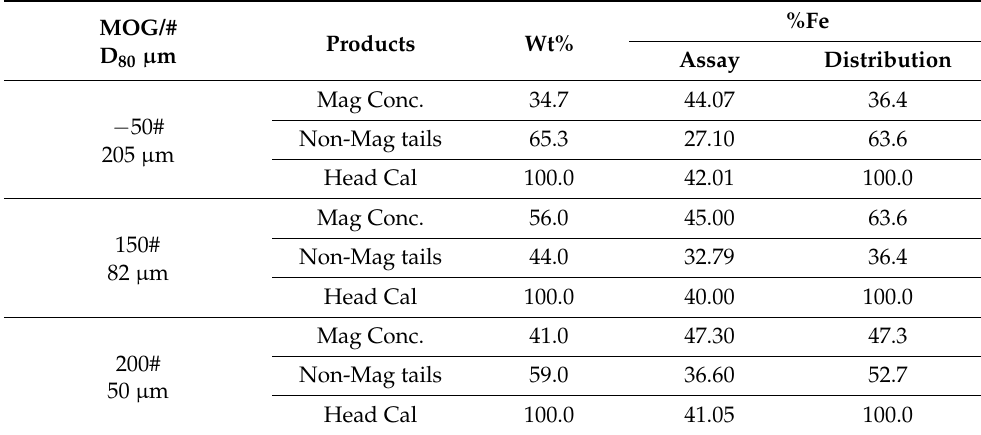
Table 2. Effect of mesh of grind on